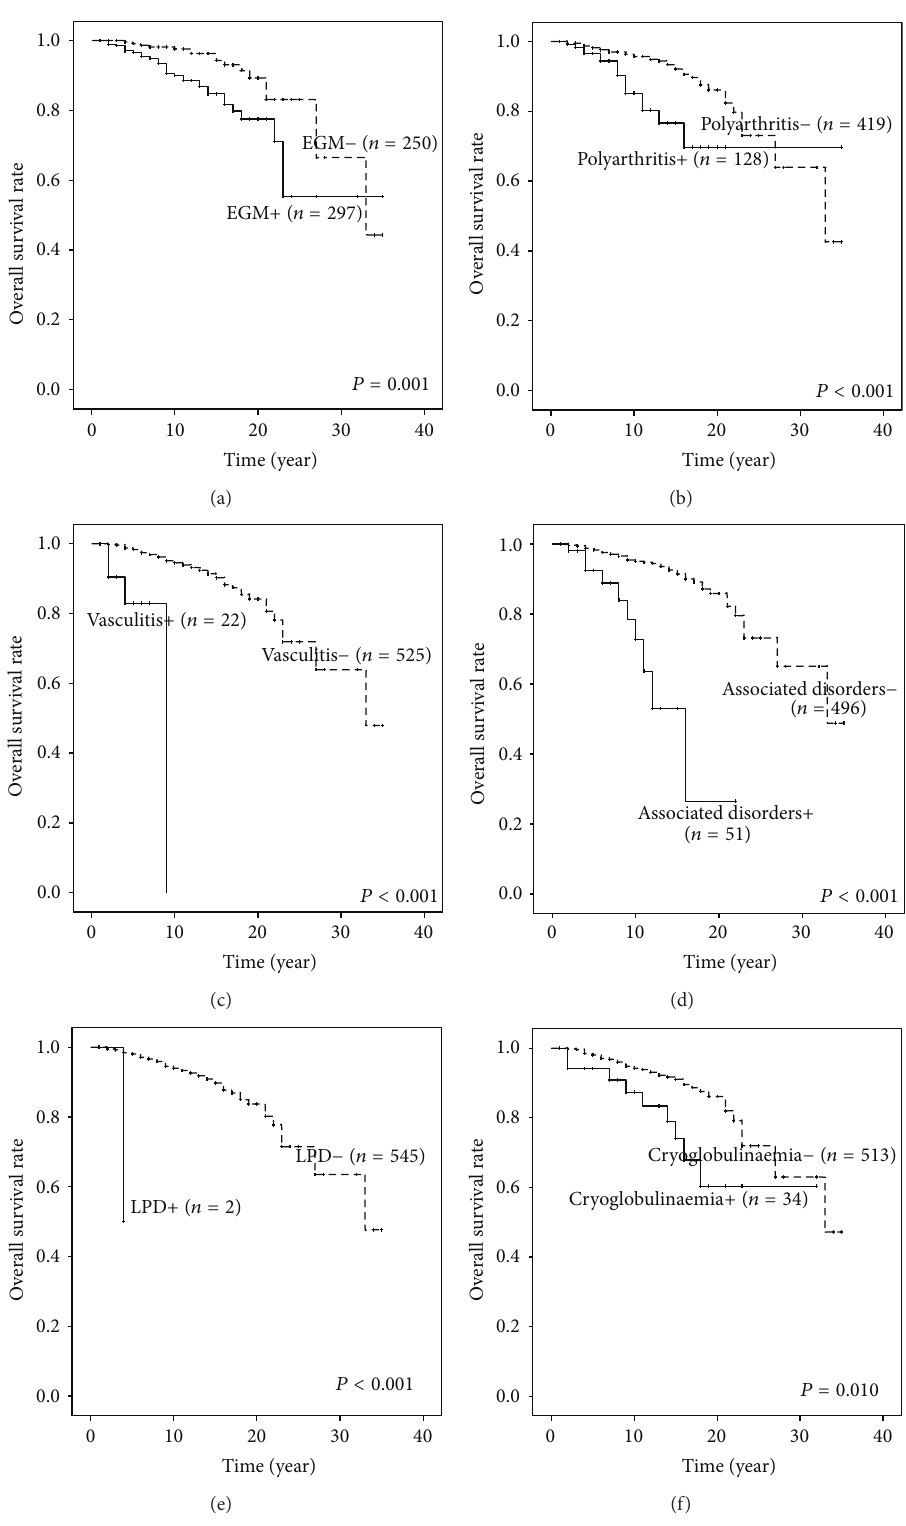
Figure 3: The Kaplan-Meier survival plots for the risk of death in patients subgroups with/without (a) extraglandular manifestations, (b) polyarthritis, (c) vasculitis, (d) associated disorders and (e) lymphoproliferative disease developed already at the time of diagnosis, or (f) cryoglobulinemia developed during the disease